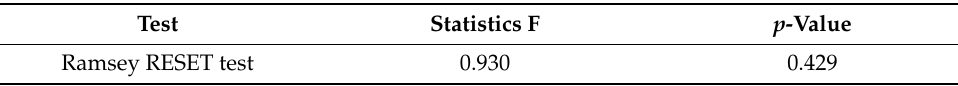
Table A9. The results of the second model specification test.